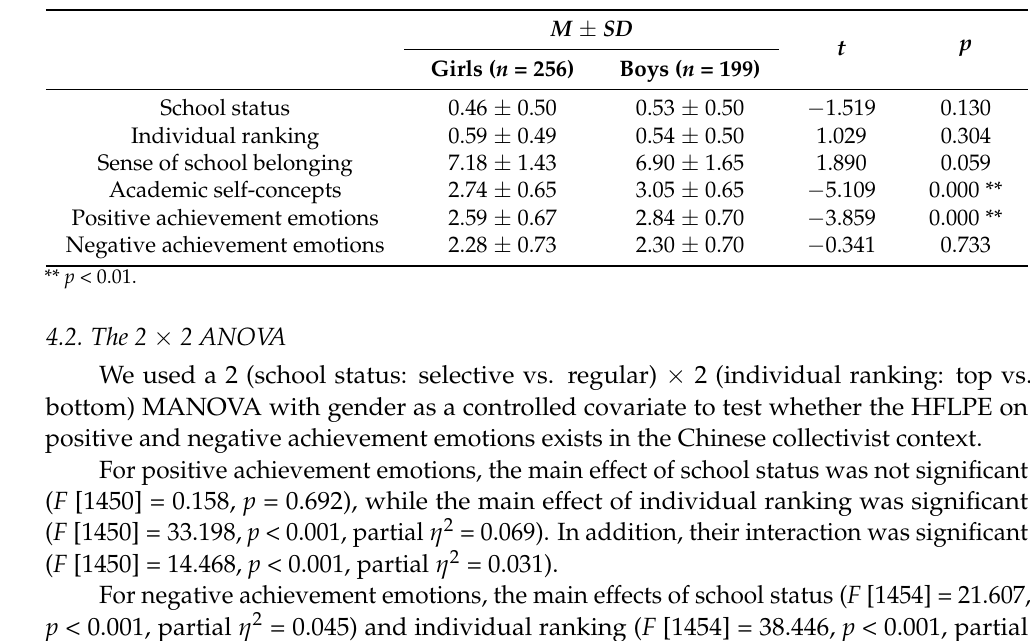
Table 3. Gender differences in the study